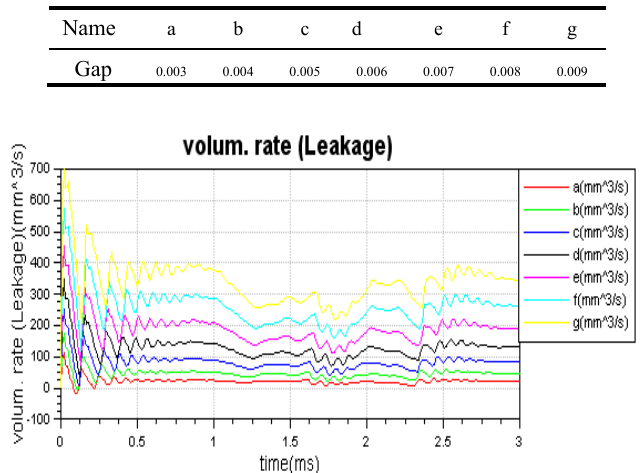
Fig.8 the leakage rate of fuel in control chamber